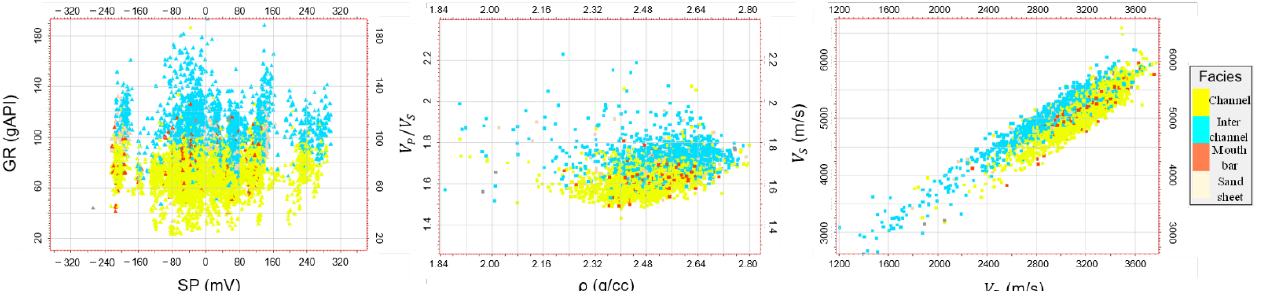
Figure 11. Data interpretation results for the 11 wells in the inversion block: ( a ) lithofacies, ( b ) density, ( c ) p-wave velocity, and ( d ) s-wave velocity.